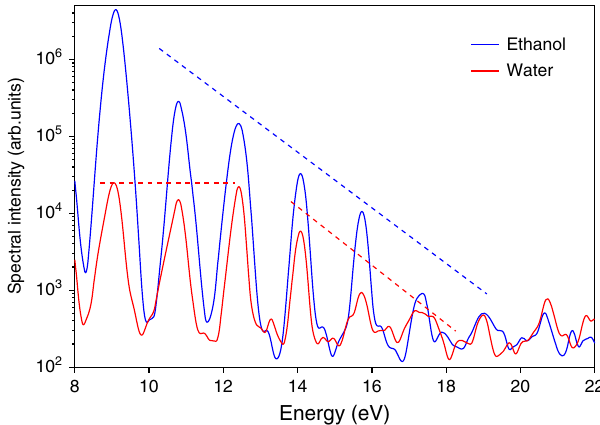
Fig. 9 Weak dependence of HHG spectra on propagation effects. HHG spectra retrieved from coupled Maxwell-SBE calculations including propagation over the thickness of the jet using the band structures of water (solid red line) and ethanol (solid blue line) described in the main text. Dashed straight lines are guides to the eye. All characteristic features obtained from the SBE calculations (Fig. 4 of the main text) are preserved, including the uniform decrease in the ethanol HHG spectrum, as well as the plateau and the dip at H13 in the water HHG